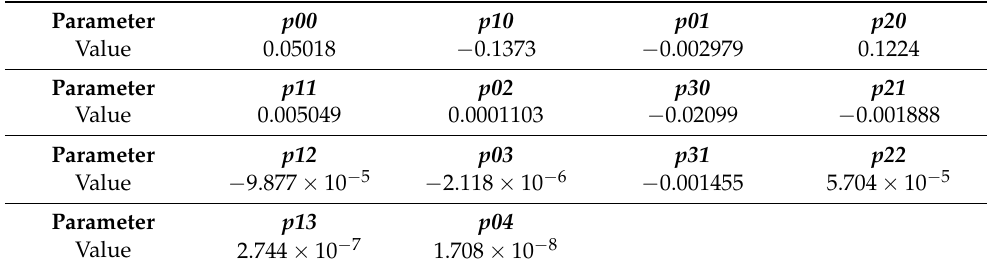
Table 5. Correlation parameters between RC Network R 2 and SOC/internal temperature.